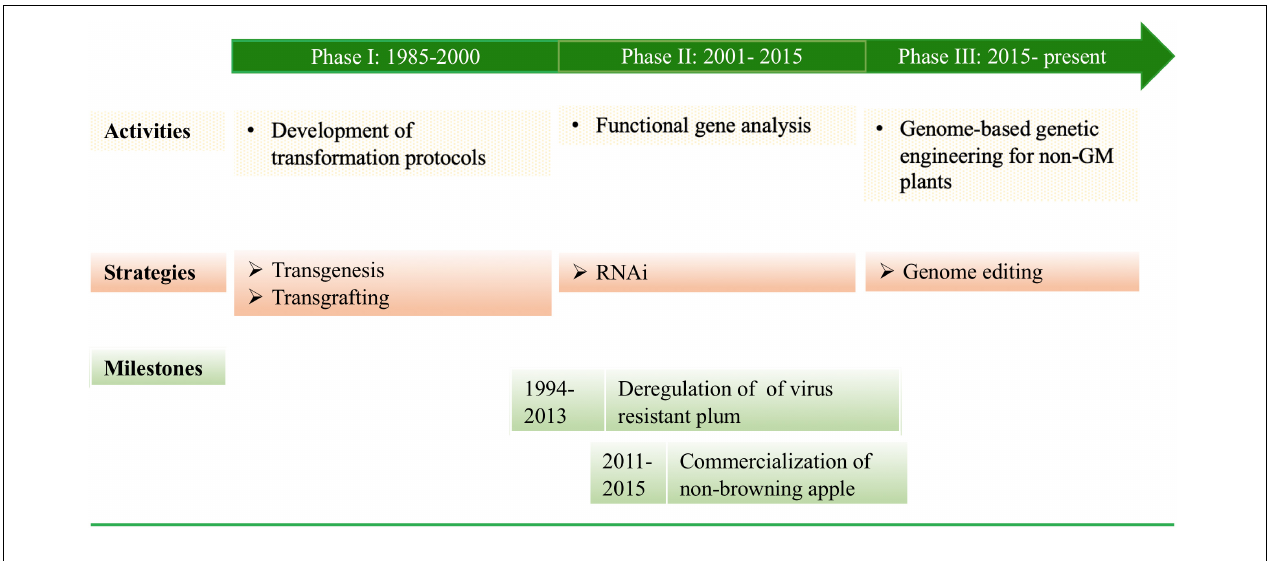
FIGURE 1 | Milestones in genetic transformation of F&N crops.